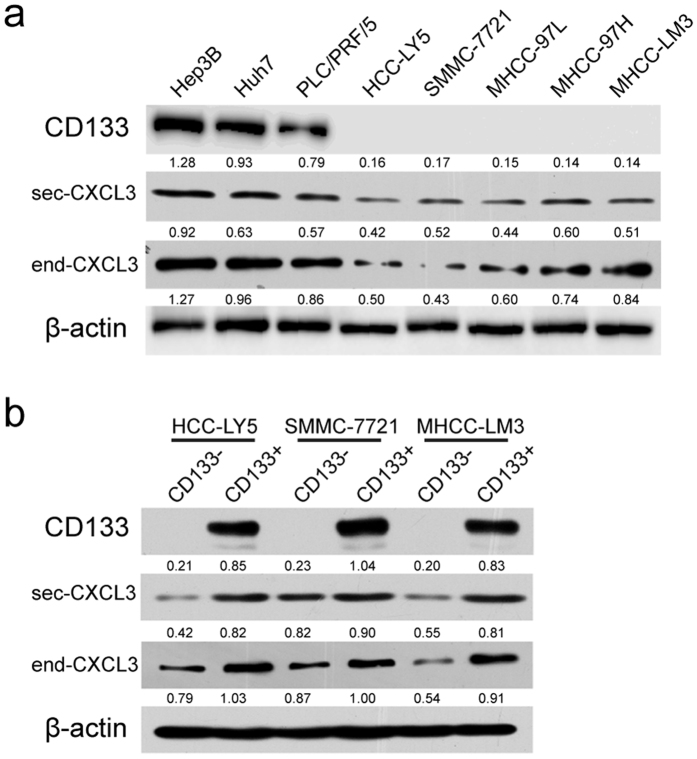
CXCL3 was differentially expressed in CD133+/CD133− cell population of HCC cell lines.(a) Western blotting analysis of CD133, secreted and endogenous CXCL3 proteins expression in HCC cell lines. The gels in the same panel mentioned in this article had been run under the same experimental conditions. Uncropped full-length blots were showed in the Supplementary Fig. S4A. (b) CD133+ HCC cells expressed higher level of secreted and endogenous CXCL3 proteins compared with the corresponding CD133− cells. Uncropped full-length blots were showed in the Supplementary Fig. S4B.